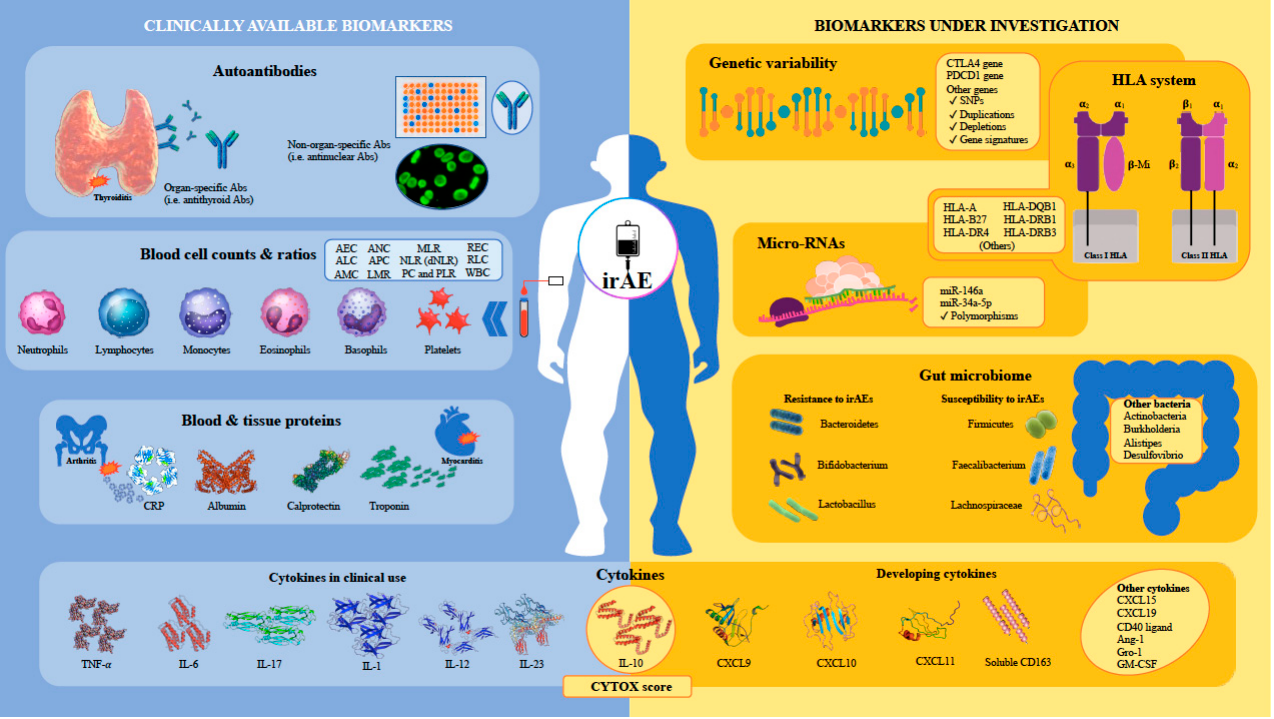
Figure 1. Graphical representation of different families of predictive biomarkers for immune-related adverse events in patients receiving immune-checkpoint inhibitors. Abbreviations in alphabetical order: Abs, antibodies; AEC, absolute eosinophil count; ALC, absolute lymphocyte count; AMC, absolute monocyte count; ANC, absolute neutrophil count; Ang-1, angiopoietin-1; APC, absolute platelet count; CD40, cluster of differentiation 40; CRP, C-reactive protein; CTLA4, cytotoxic T-lymphocyte-associated antigen 4; CXCL, chemokine ligand; dNLR, derived neutrophil-to-lymphocyte ratio; GM-CSF, granulocyte-macrophage colony-stimulating factor; gro-1, growth-regulated oncogene-1; HLA, human leucocyte antigen; IL, interleukin; irAE, immune-related adverse event; LMR, lymphocyte-to-monocyte ratio; miR, micro-RNA; MLR, monocyte-to-lymphocyte ratio; NLR, neutrophil-to-lymphocyte ratio; PC, platelet count; PDCD1, programmed cell death protein 1; PLR, platelet-to-lymphocyte ratio; REC, relative eosinophil count; RLC, relative lymphocyte count; sCD163, soluble cluster of differentiation 163; SNP, single nucleotide polymorphism; TNF- α , tumor necrosis factor-alpha; WBC, white blood